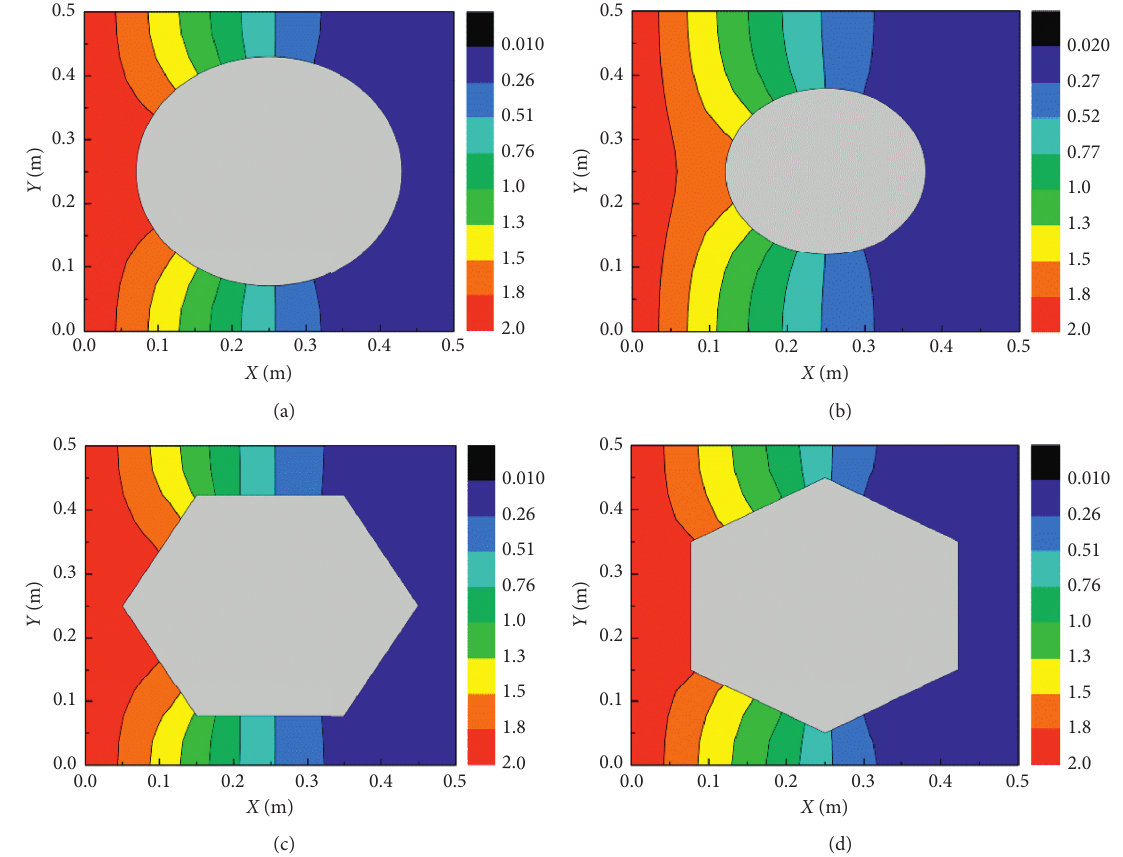
Figure 3: The distribution of chloride concentration in concrete ( t � 5 years). (a) 40% circular aggregate. (b) 20% circular aggregate. (c) 40% polygonal aggregate. (d) 20% polygonal aggregate.